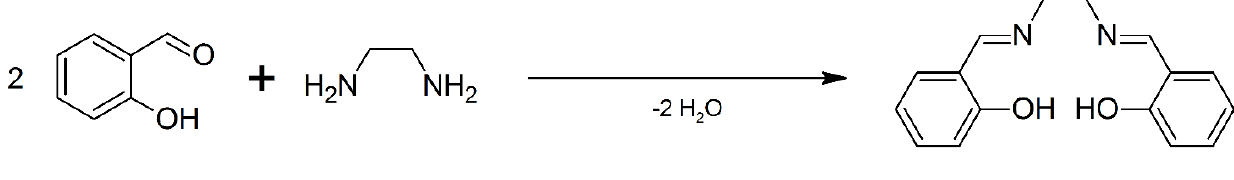
Figure 1. Synthesis of the Schiff base H 2